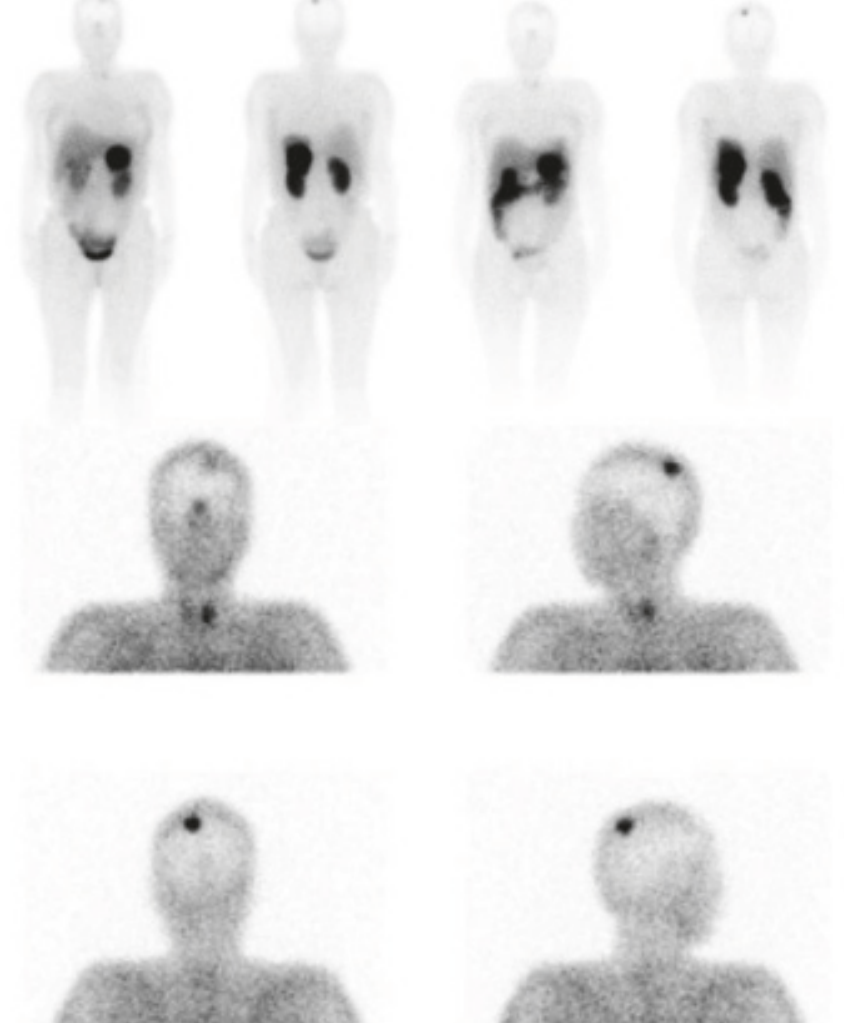
Figure 3: OctreoScan showing a pathological deposit at the upper left parietal level caused by meningioma and in the tail of